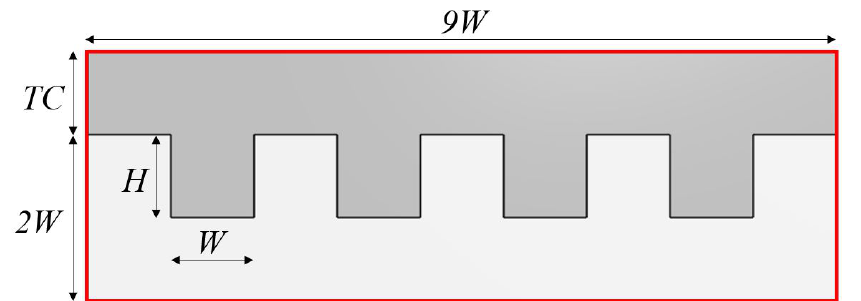
Figure 2. Sketch of the inlet cross section (outlined with red colored lines) and the flow cross section in the channels region (gray